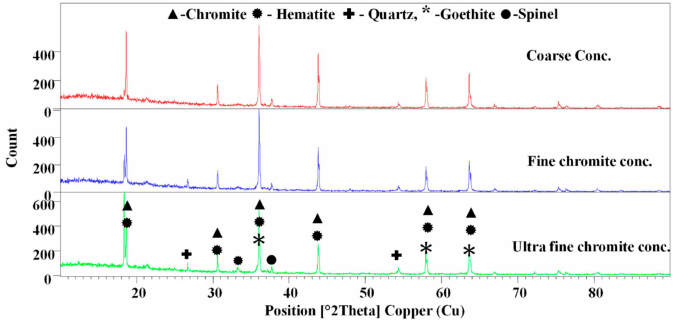
Figure 2. XRD pattern of the chromite concentrates.